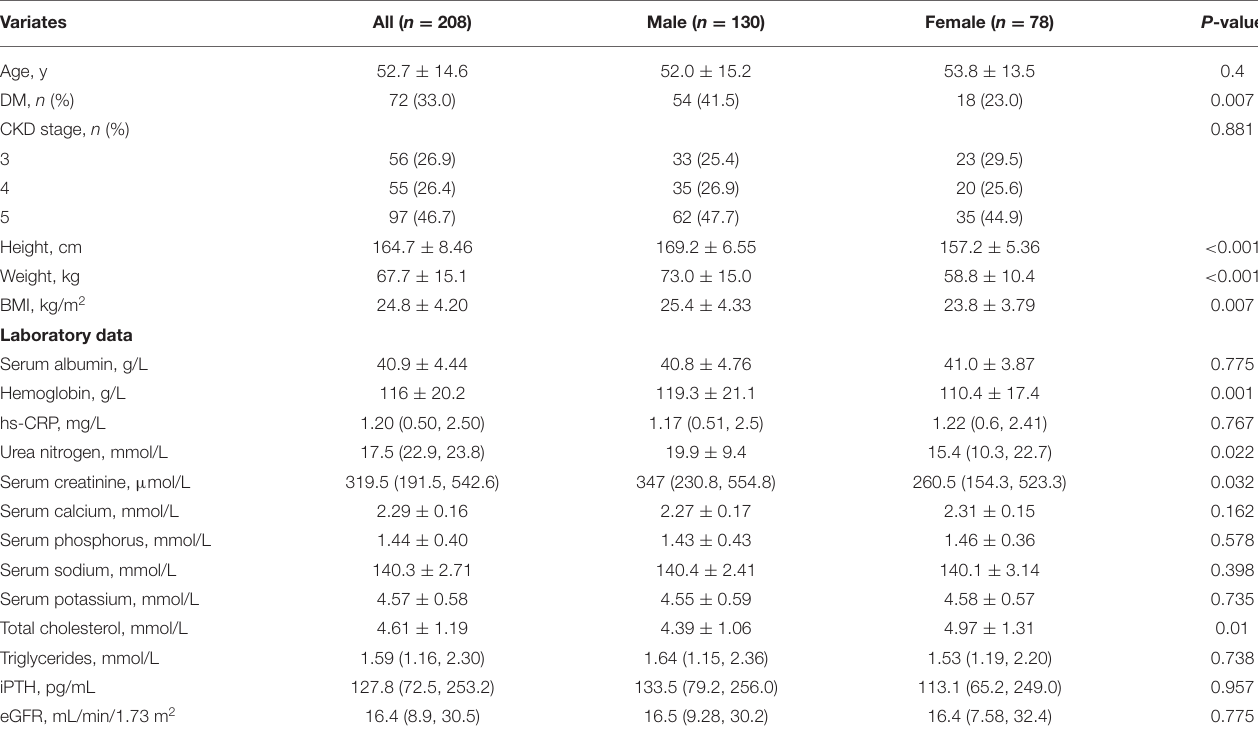
TABLE 1 | Demographic and clinical characteristics of CKD patients in male and female groups.